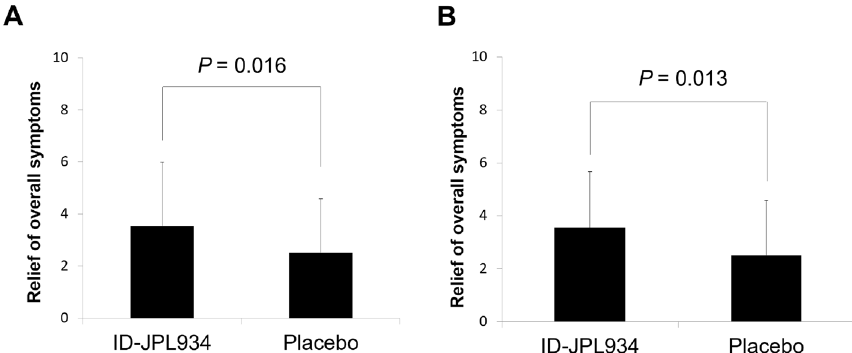
Figure 1. Relief of overall symptoms in the ID-JPL934 group vs. placebo group after 8-week treatment. ( A ) Intention-to-treat analysis (n = 112). ( B ) Per protocol analysis (n = 104). A significantly higher relief of overall symptoms was observed in the ID-JPL934 than in the placebo group. P -values were calculated using Student’s t-test.